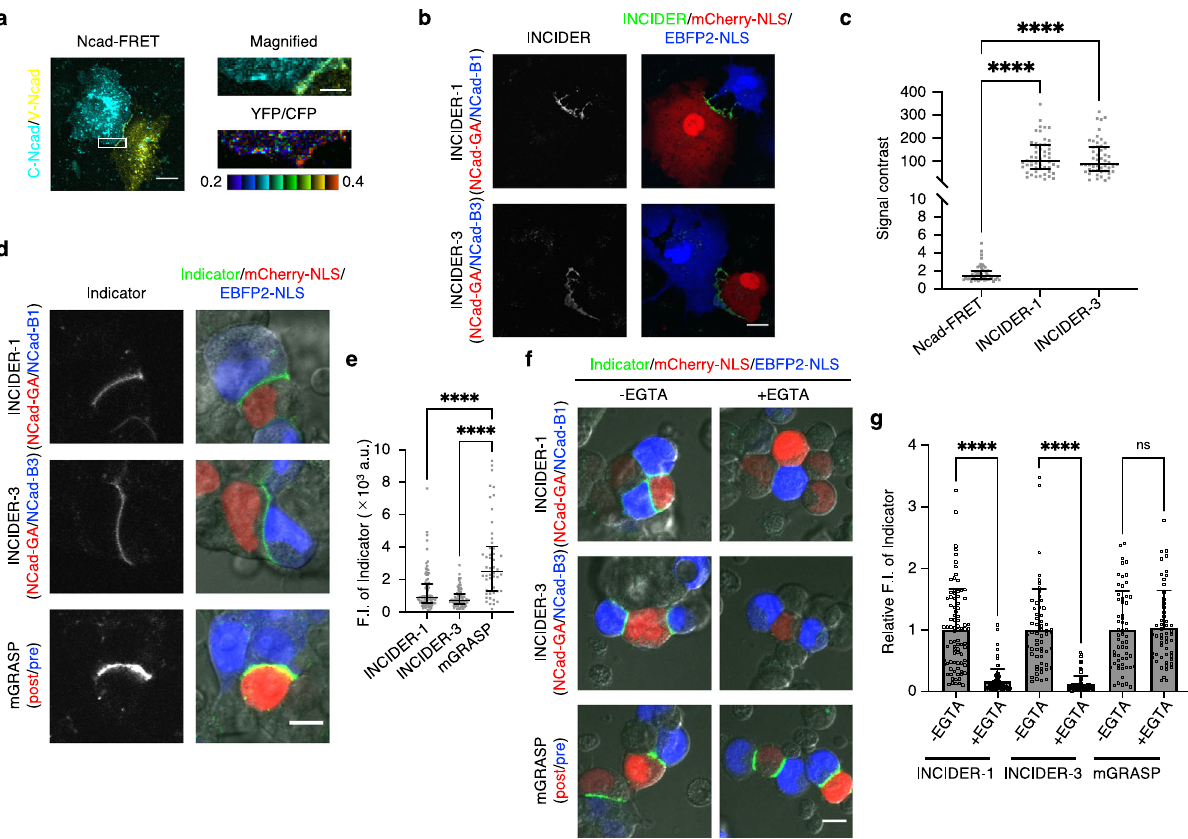
Fig. 5 Comparison between INCIDERs and conventional indicators for cell – cell interactions. a NCad interaction monitored by the FRET-based NCad indicator (Ncad-FRET) in COS7 cells. COS7 cells expressing the indicated constructs were co-cultured. The FRET signal at the cell adhesion site is displayed as a YFP/CFP ratio (bottom right). Scale bar, 20 μ m (left), 5 μ m (upper right). b NCad interaction monitored by INCIDERs in COS7 cells. COS7 cells expressing the indicated constructs were co-cultured. mCherry-NLS and EBFP2-NLS are hallmarks of NCad-GA and NCad-B expressing cells, respectively. Scale bar, 20 μ m. c The signal contrast between cell adhesion sites and non-cell adhesion sites. The signal contrast of Ncad-FRET was calculated by dividing the YFP/CFP ratio at the cell adhesion sites by that at the non-cell adhesion sites of the cells expressing C-Ncad. The signal contrast of INCIDERs was calculated dividing the fl uorescence intensity of INCIDERs at the cell adhesion sites by that at the non-cell adhesion sites of the cells expressing NCad-GA. Data are presented as lower quartile (lower whisker), median (center line), and upper quartile (upper whisker). A signi fi cant difference was shown by a Kruskal-Wallis test, followed by a Dunn ’ s multiple comparison test. **** p < 0.0001. 50 (Ncad-FRET), 52 (INCIDER-1), and 50 (INCIDER-3) cell adhesion sites from four independent experiments were analyzed. d Comparison of brightness between INCIDERs and mGRASP. HEK293T cells transiently expressing the indicated components were co-cultured. Scale bar, 10 μ m. e Fluorescence intensities of the indicators at the cell adhesion sites were quanti fi ed. Data are presented as lower quartile (lower whisker), median (center line), and upper quartile (upper whisker). Signi fi cant differences were analyzed by Kruskal-Wallis test, followed by Dunn ’ s multiple comparison test. **** p < 0.0001. 90 (INCIDER-1), 98 (INCIDER-3), and 50 (mGRASP) cell adhesion sites from two independent experiments were analyzed. f Comparison of reversibility between INCIDERs and mGRASP. HEK293T cells transiently expressing the indicated components were co-cultured for 6 h, and then co-cultured in the presence or absence of 10 mM EGTA for further 2 h. Scale bar, 10 μ m. g Fluorescence intensities of the indicators at the cell – cell contact sites in the presence or absence of 10 mM EGTA were quanti fi ed and normalized by the mean values in the absence of 10 mM EGTA. Data are presented as relative mean values ± SD. Signi fi cant differences were analyzed by Mann – Whitney U -test. **** p < 0.0001. 87 (-EGTA, INCIDER-1), 81 ( + EGTA, INCIDER-1), 59 (-EGTA, INCIDER-3), 76 ( + EGTA,